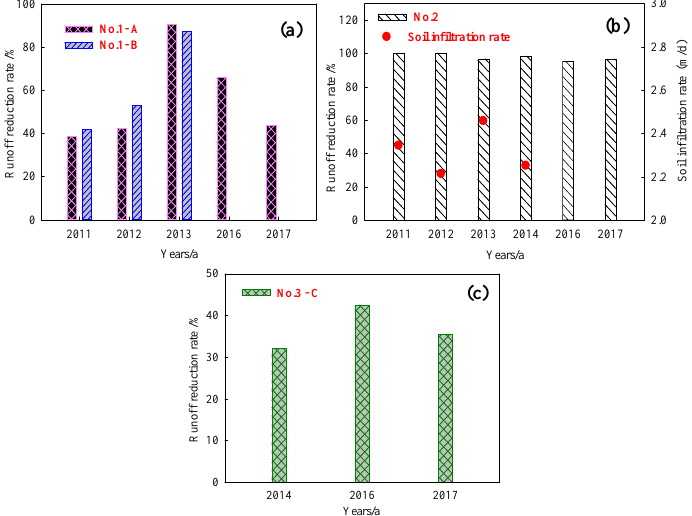
Figure 7. Runoff reduction of three rain gardens. ( a ) The annual average runoff reduction rate in rain garden No. 1A and B from 2011 to 2017; ( b ) The annual average runoff reduction rate and soil infiltration rate in rain garden No. 2 from 2011 to 2017; ( c ) The annual average runoff reduction rate in rain garden No. 3C from 2014 to